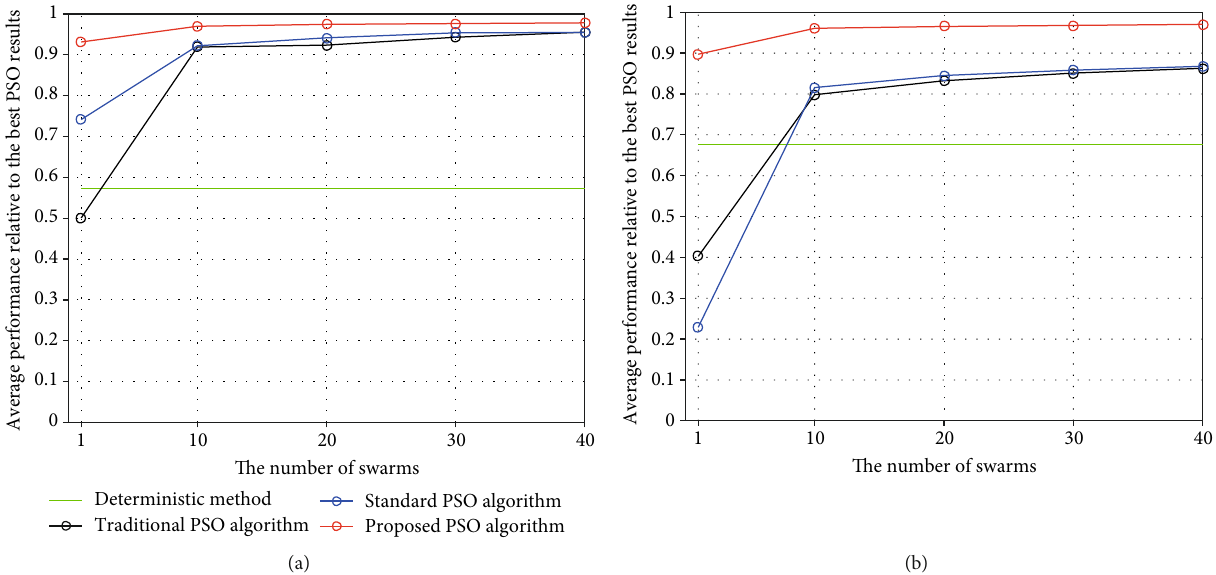
Figure 19: Average performance comparison according to the number of swarms used in the multi-swarm PSO algorithm for the short-range test cases (a) and the long-range test cases (b).